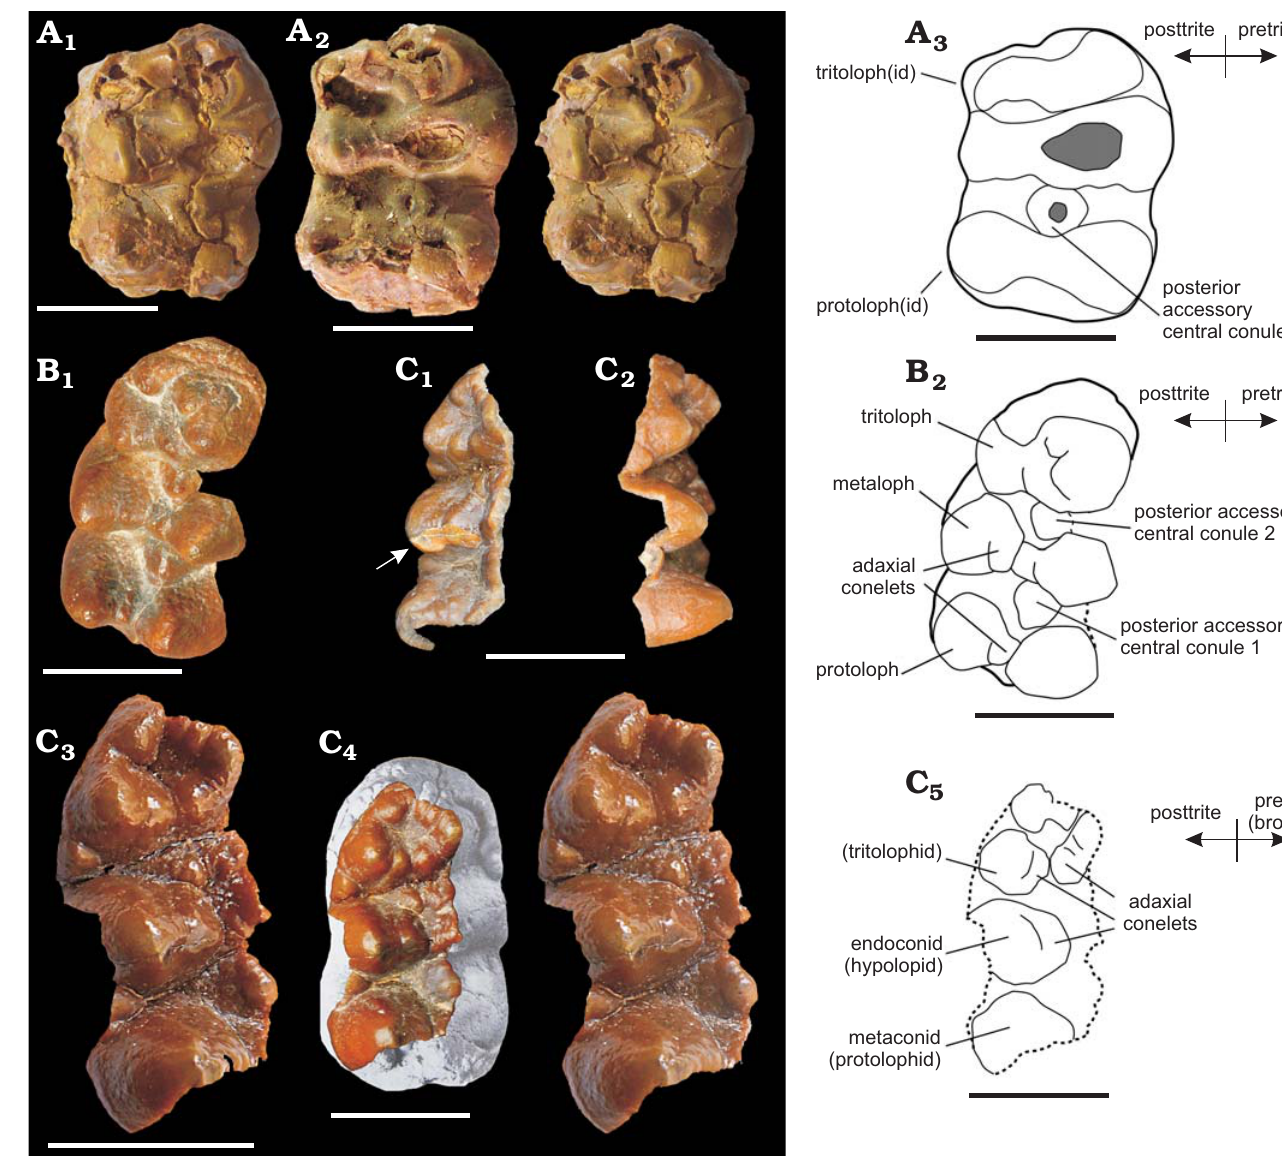
Fig. 6. Molars of palaeomastodontid proboscideans cf. Phiomia sp. (A, B) and Phiomia sp. (C) from the BOTM, early Oligocene, Minqar Tibaghbagh, Qattara Depression, Egypt. A . Left M3 or M2 (CGM67199) in occlusal view (A 1 stereopair; A 2 , reconstruction; A 3, line drawing based on this reconstruc- tion). A 2 has been reconstructed by removing the fissures with Photoshop. B . Left M3? (CGM67189) in occlusal view (B 1 , photograph; B 2 , line drawing). C . Left m3 (CGM67187) in lingual (C 1 , arrow points at wear facet), buccal (C 2 ), and occlusal (C 3 stereopair; C 4 , reconstruction; C 5 , line drawing)